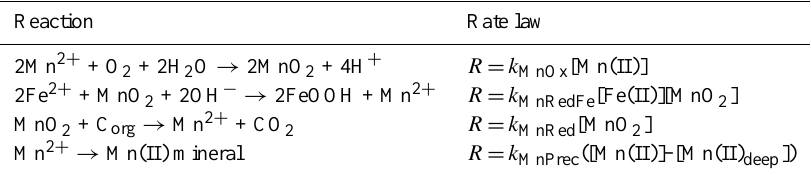
Table 5. Reactions and Rate laws used in the 1-D